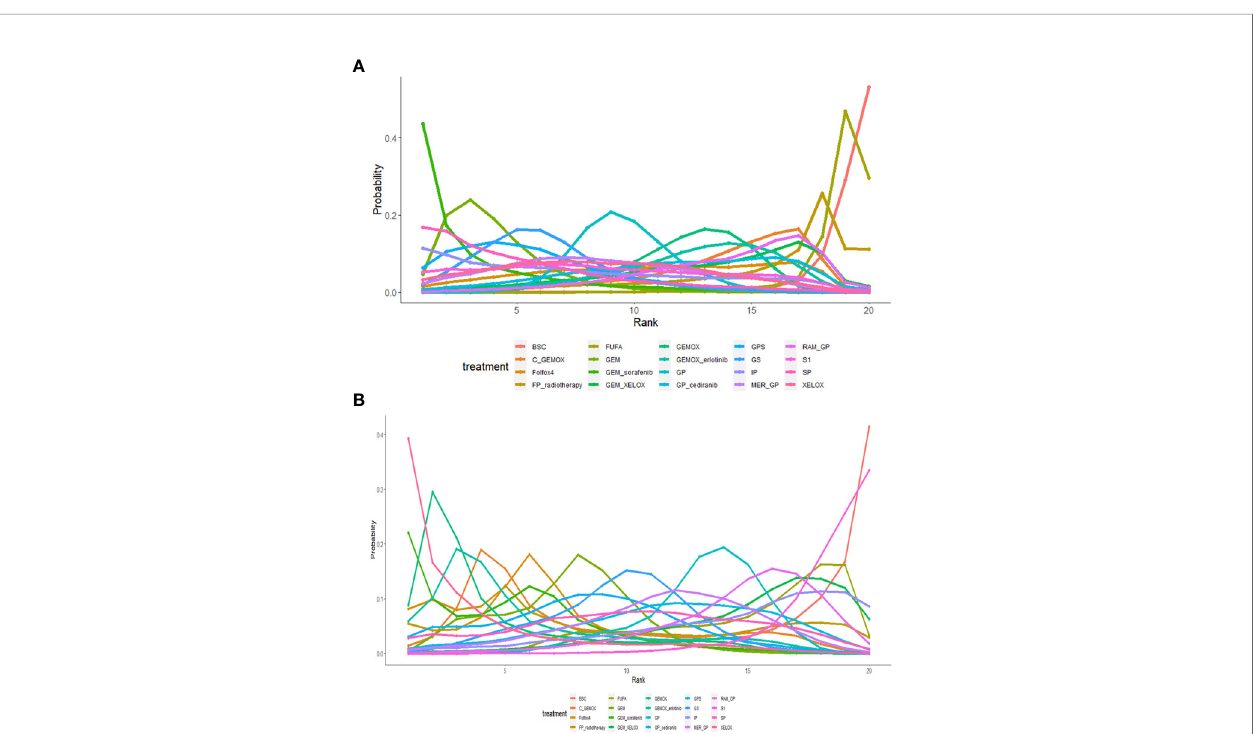
FIGURE 4 | (A) The ef fi cacy ranking line diagram of overall survival (OS) of each protocol; (B) the ef fi cacy ranking line diagram of progression-free survival (PFS) of each